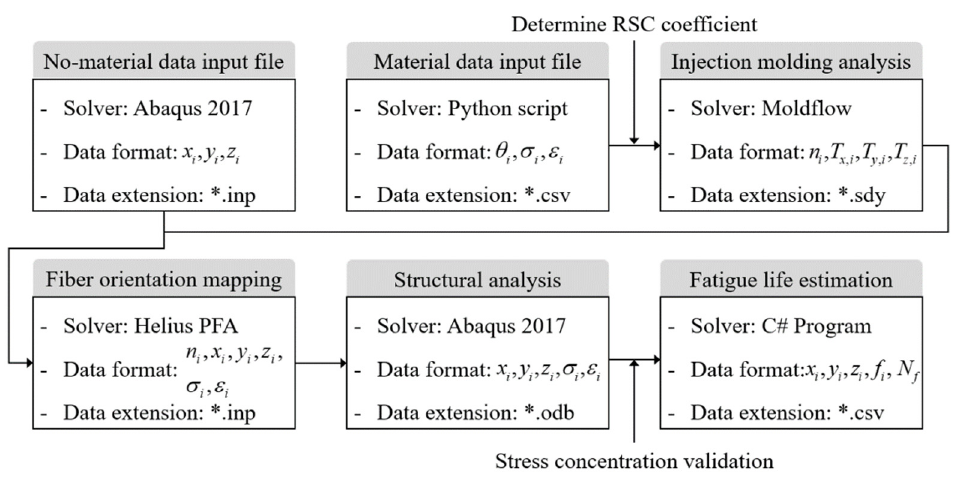
Figure 4. The one-way coupled injection molding-structure numerical analysis procedure for fatigue life prediction of CFRPs.